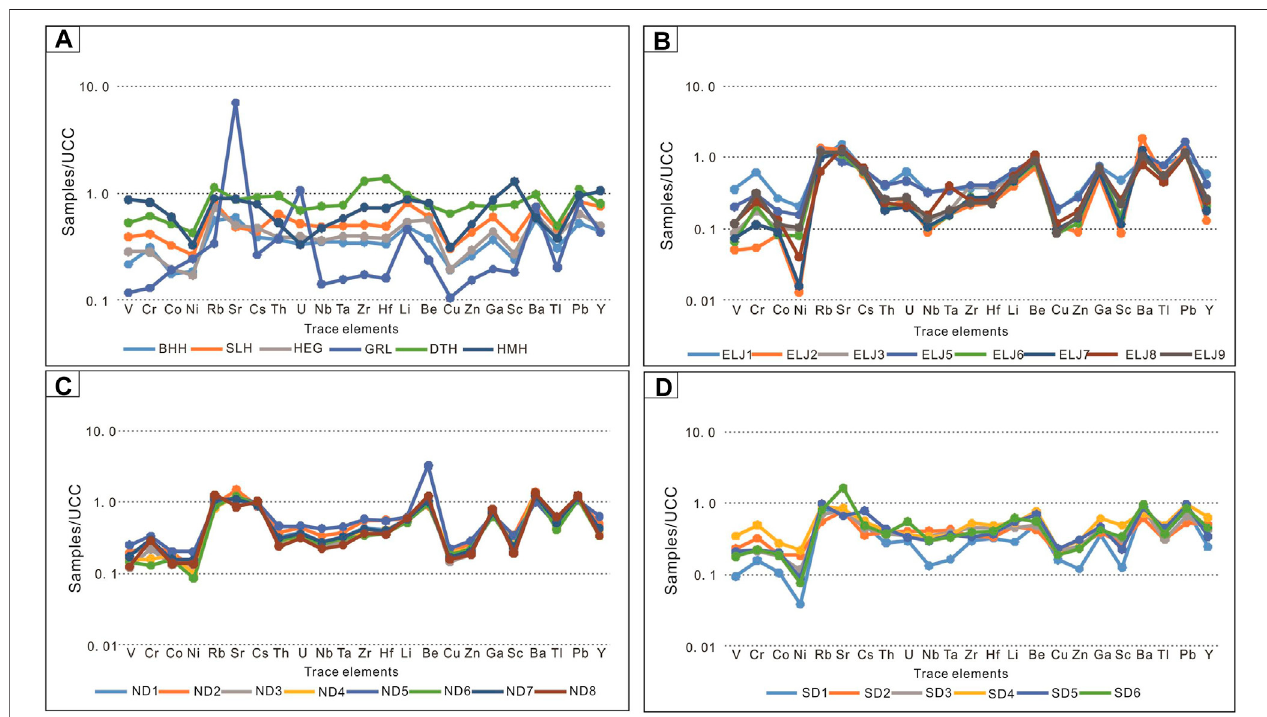
FIGURE 6 | UCC-normalized trace element patterns for different samples from the Qinghai Lake area. (A) Samples from rivers and GRL foreshore, (B) samples from Erlangjian beach bar (ELJ), (C) samples from Niaodao beach (ND), and (D) samples from aeolian sand dune (SD), respectively.